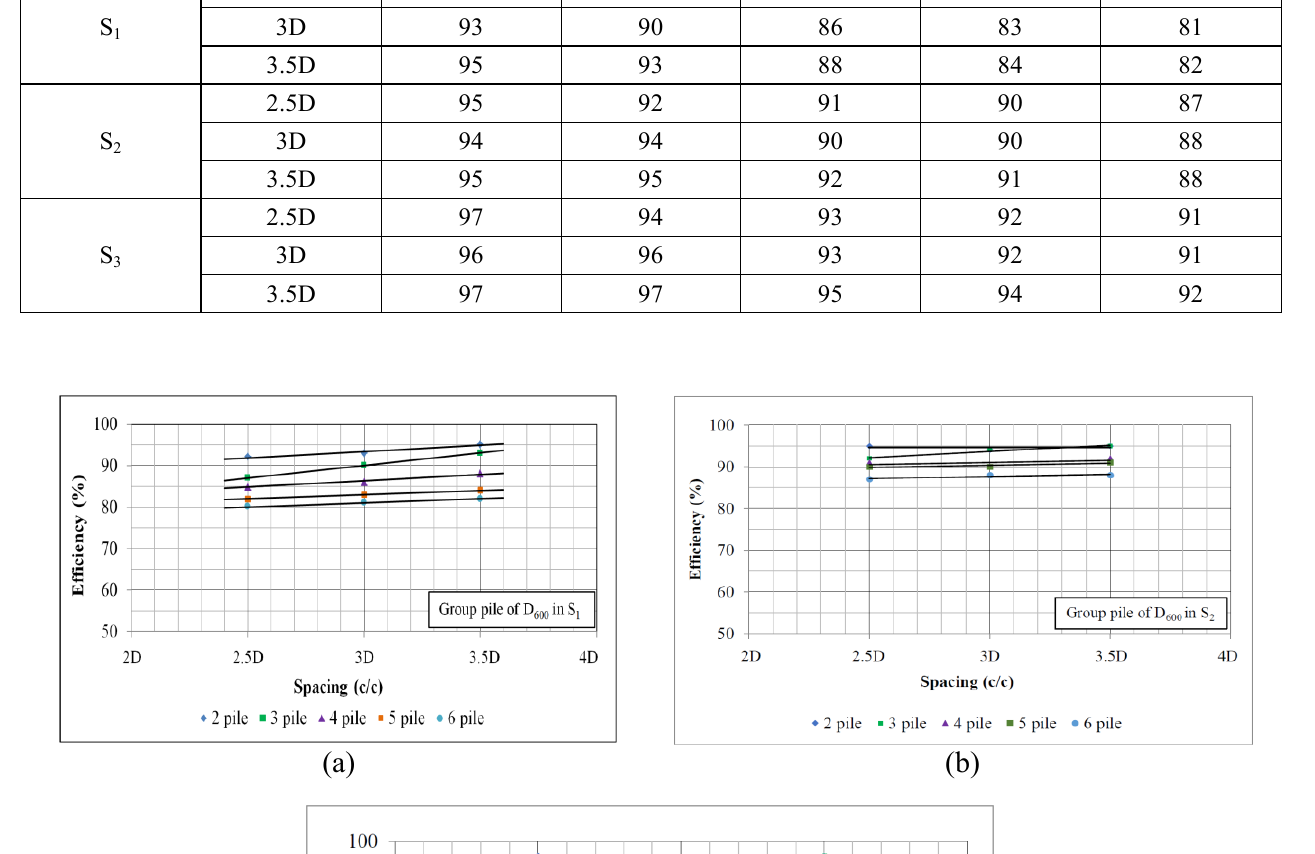
Group pile efficiencies of D Soil type